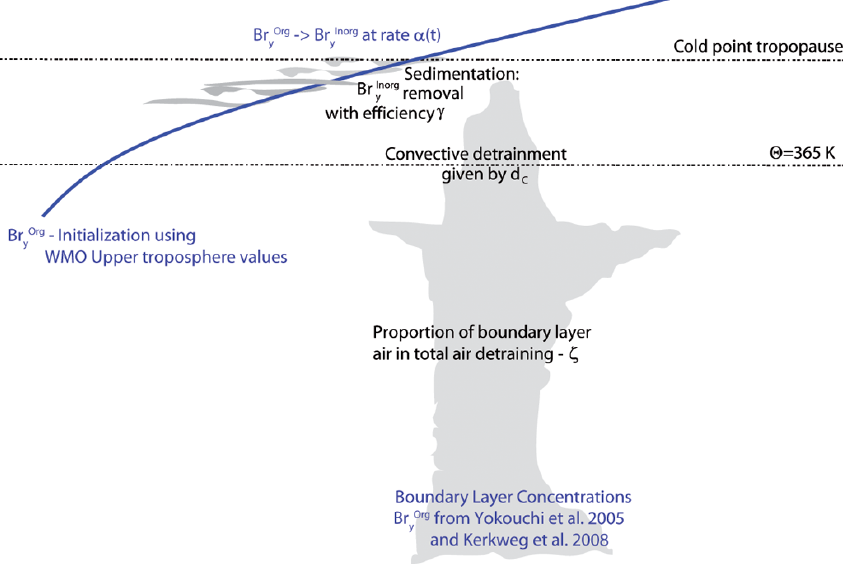
Fig. 1. Schematic illustration of the conceptualised model. The blue line is a single trajectory depicting a “typical” air parcel traversing 365–400K. Each air parcel trajectory experiences convective injection of organic bromine delivered from the BL and the FT (with the BL component given by ζ between 0 and 1). From t 0 inorganic bromine from SLS loss forms at an overall rate given by α , determined cumulatively from all of SLS bromine species’ lifetimes. As the air parcel dehydrates at cold temperatures, the available inorganic bromine washes out with an efficiency γ (between 0 and 1). After the CPT is crossed possible introduction of additional organic bromine via convection contributes to the total amount of bromine reaching